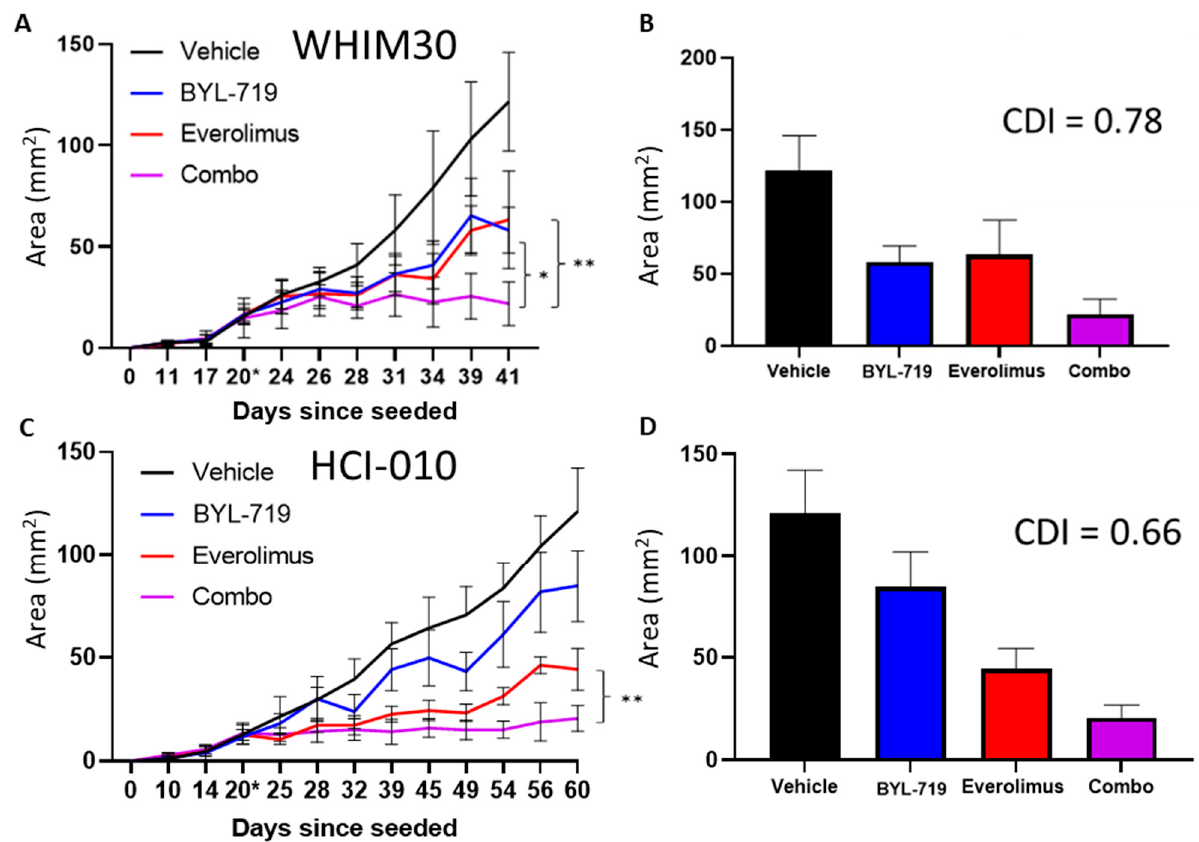
Figure 10. The combination of everolimus with BYL-719 performed better than the expected addi- tive effects of both drugs in the PTEN-deficient WHIM30 and HCI-010. BYL-719 tested in vivo in WHIM30, compared to alternative single agents everolimus and the combination with BYL-719 in ( A , B ) WHIM30 and ( C , D ) HCI-010. * denotes p < 0.05, ** denotes p < 0.001 significance, ANOVA after Tukey correction for multiple comparisons, comparing final tumor area. * on the days since seeded axis denotes the day that the treatment was started.